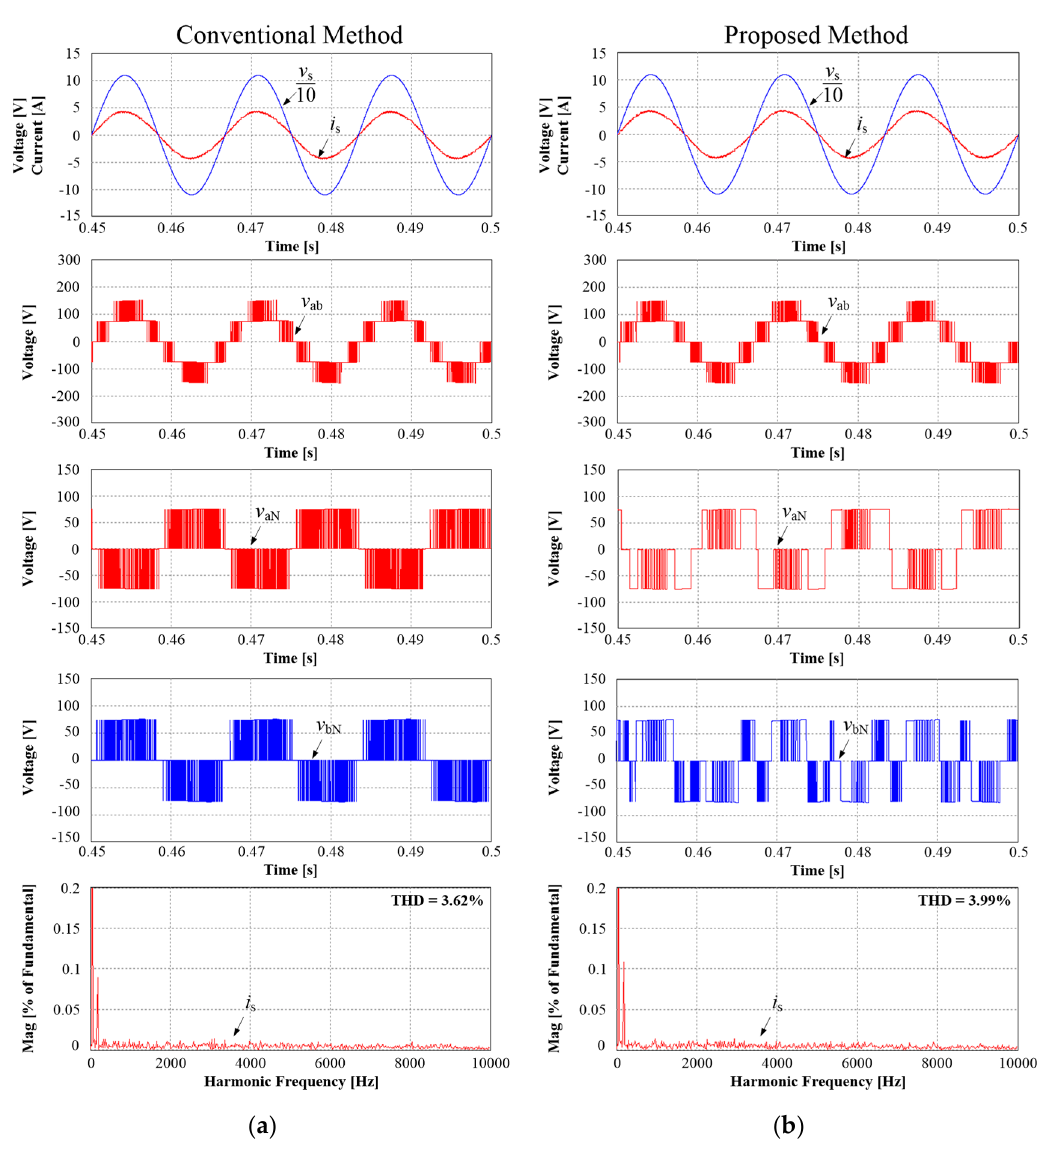
Figure 8. Simulation results of ac source current ( i s ), source voltage ( v s ), converter line-to-line voltage ( v ab ), pole voltages ( v aN, v bN ), and frequency spectrum of input current ( i s ) obtained by ( a ) conventional and ( b ) proposed methods.